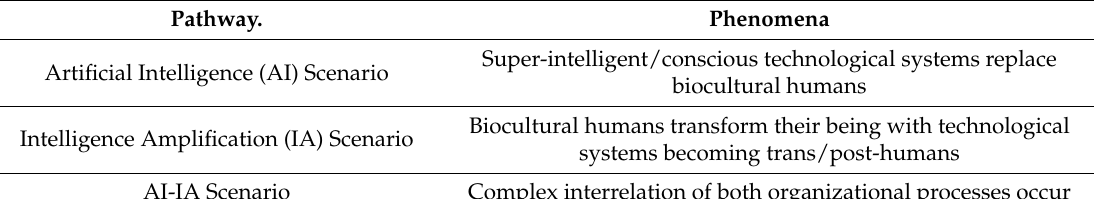
Table 1. Potential large-scale singularity consequences for self-consciousness. The radical unknown and unpredictable future horizon of human becoming in relationship to scientific advancements in robotics, artificial intelligence, nanotechnology, genetics, and other possible actualizations is becoming a growing and central concern of human evolution, possibly requiring dialectical analysis. In this dialectical analysis the internal horizon of negative-affirmative ideality structures becoming around a center